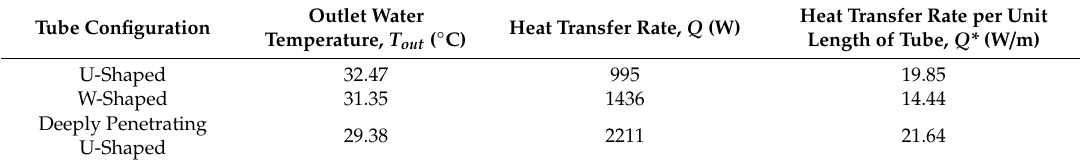
Table 6. Comparison of thermal performance for three di ff erent tube configurations.